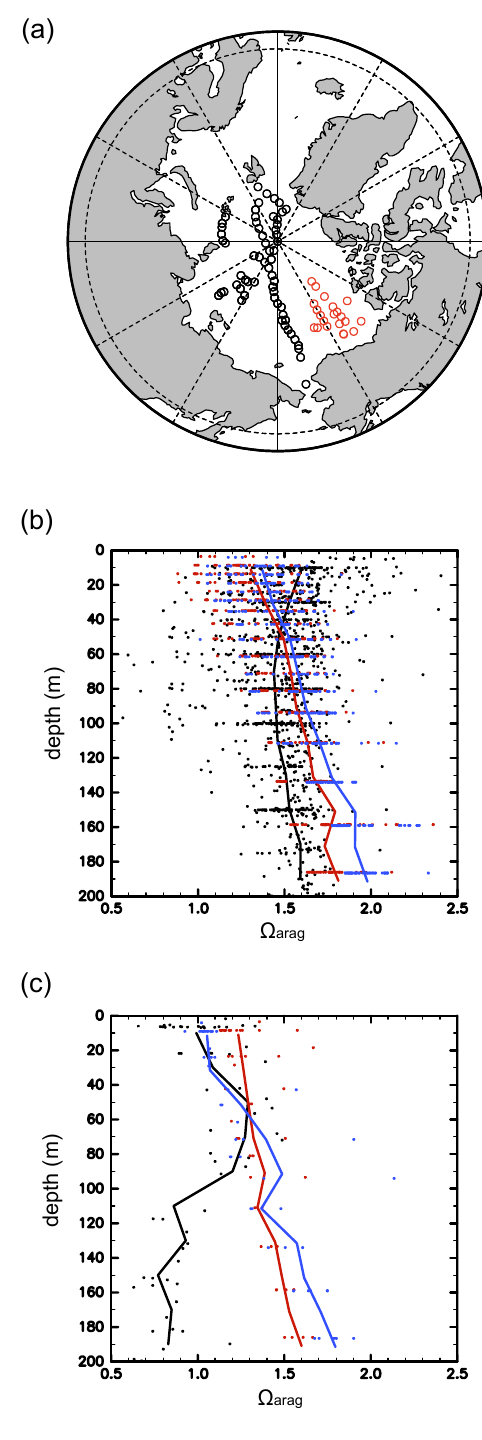
Fig. 3. (a) Observation sites of ODEN-91, AOS-94, and ARCSYS- 96 (black open circle), and JOIS 2008 (red open circle). The vertical distribution of (cid:127) arag calculated from (b) ODEN-91, AOS-94, and ARCSYS-96; and (c) JOIS 2008. The dots represent raw data and lines represent horizontal average. Red and blue show (cid:127) arag calcu- lated from “C 4 MIP” and “CMIP5” for the same time and